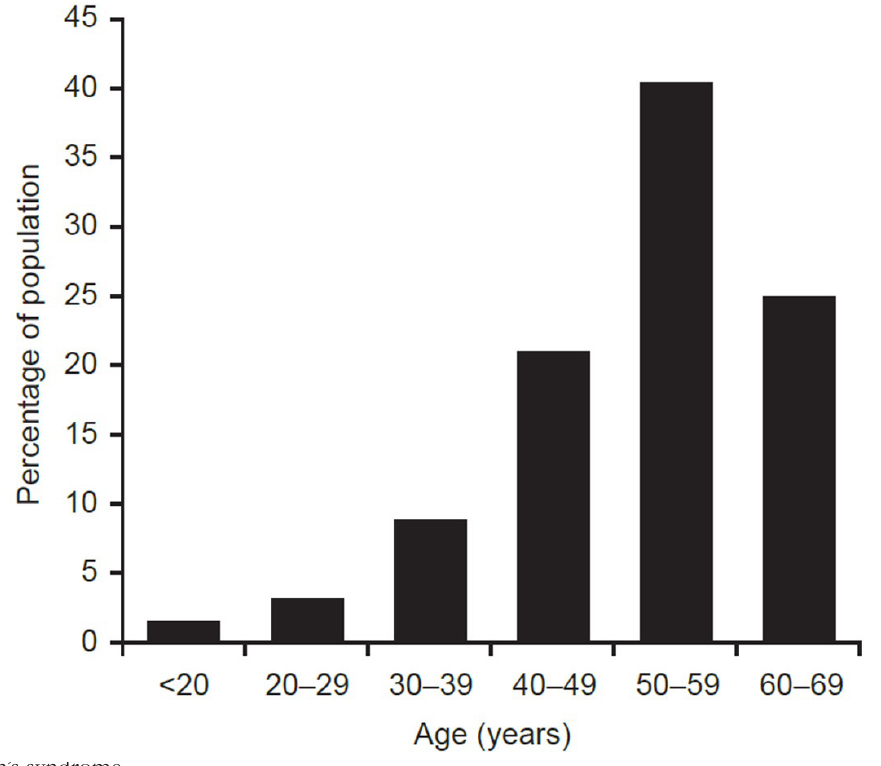
Figure 2. Age Distribution of Patients with pSS in the Primary Cohort